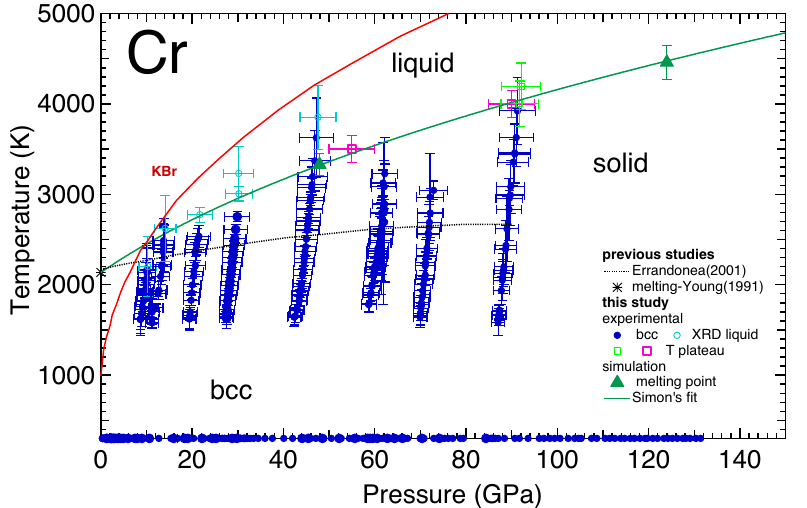
Figure 2. Phase diagram of Cr as obtained in the present study both experimentally (solid and empty circles and empty squares) and with first principle calculation (solid triangles and solid green line) and a previous study based on the speckle technique 37 (dashed black line). The melting line of KBr as reported in Briggs et al. 44 is also represented as a continuous red line for reference.